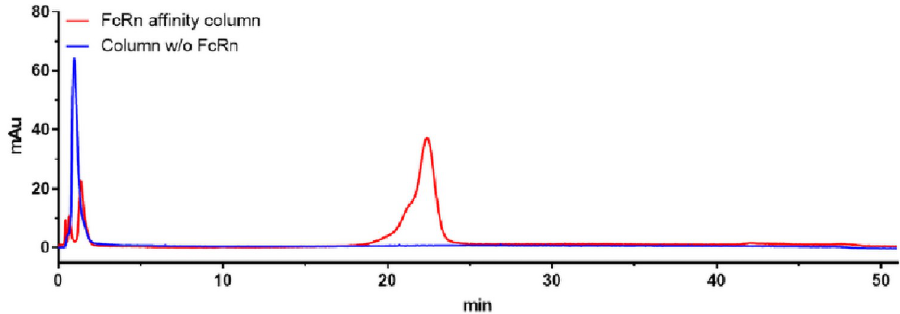
Fig 6. Negative control of mAbB3. Negative control of mAbB3 (Tm- p -SCN-Bz-DOTA) using sepharose column without FcRn (blue). The red line shows mAbB3 measured with FcRn affinity chromatography.